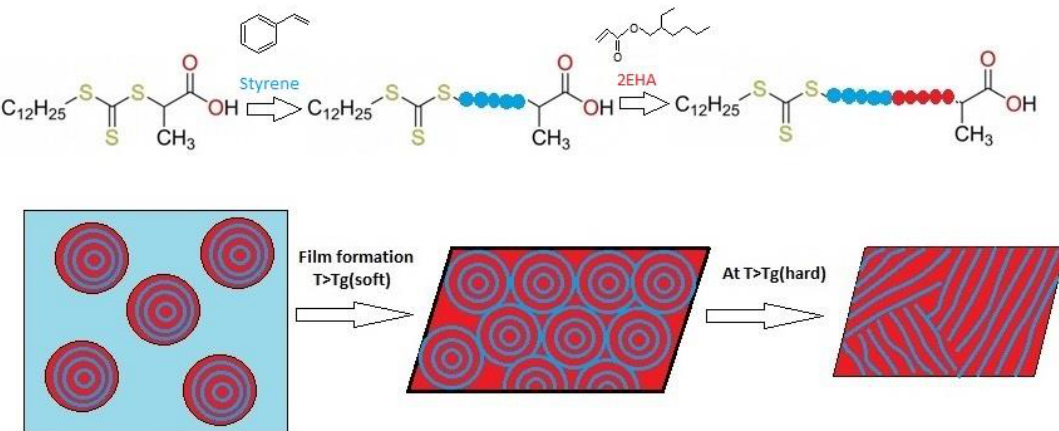
Figure 1. Chemical structure of the BM1430 reversible addition fragmentation transfer (RAFT) agent, and the expected effect of the thermoresponsiveness on the morphology of the microphase separated hard-soft block copolymers.